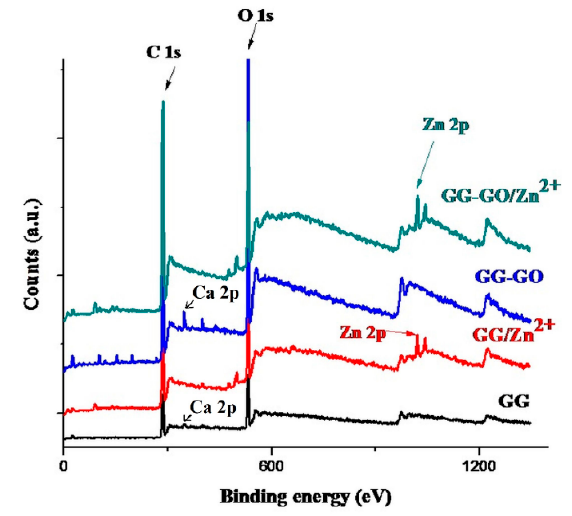
Figure 5. XPS spectra for GG; GG / GO before and after sorption of Zn (II). Table 1. Elements percentages derived from XPS